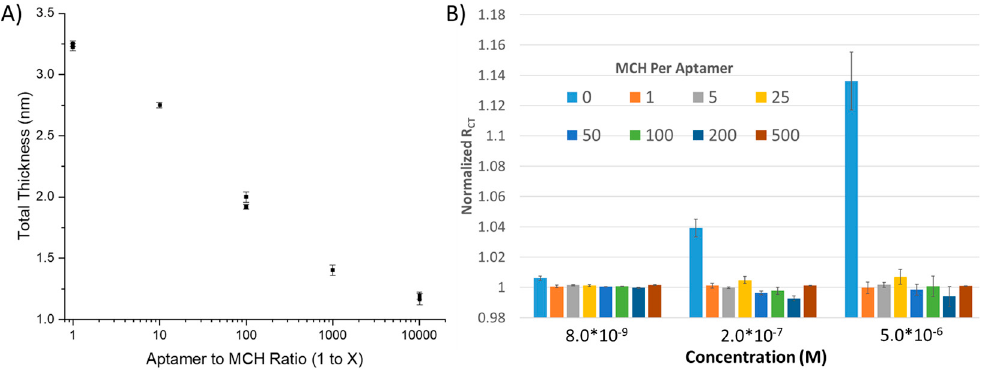
Figure 2. ( A ) Influence of Aptamer to 6-mercapto-1-hexanol (MCH) ratio to surface thickness measured using ellipsometry demonstrates efficacy of arraying MCH concentration to test various densities. ( B ) The lysozyme sensor has a substantially greater response only at the greatest SAM density.